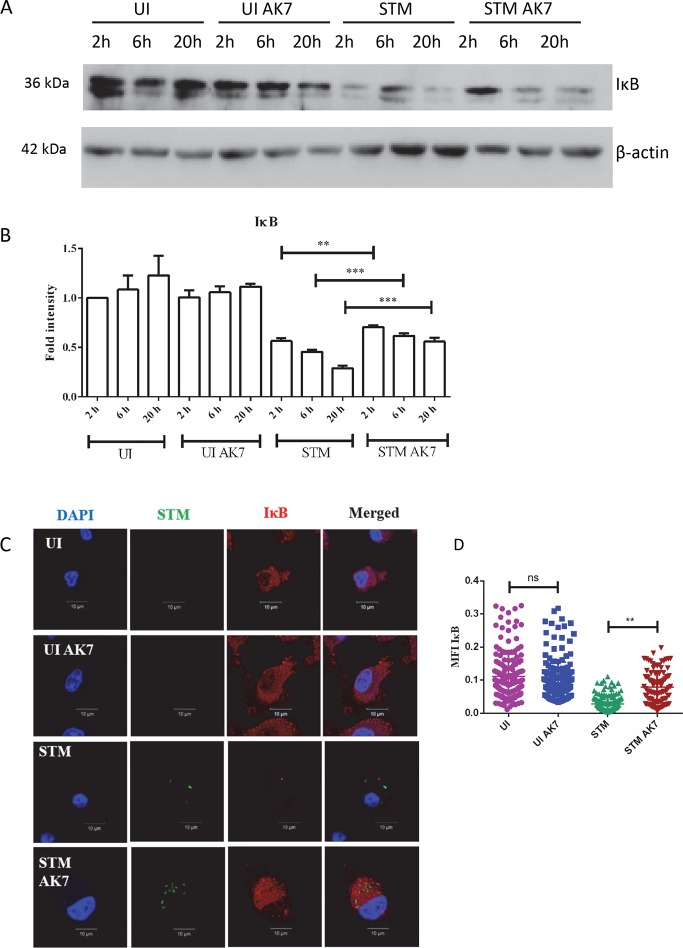
SIRT2 inhibition inhibits IκB degradation.A. Representative immunoblot of IκB in the presence and absence of SIRT2 inhibition at the indicated time point post infection. (UI- uninfected DCs, UI AK7- Uninfected DCs treated with 10 μM AK7, STM- Salmonella Typhimurium infected DCs, STM AK7- Salmonella Typhimurium infected DCs treated with 10 μM AK7). B. Densitometry analysis of IκB immunoblot in the presence and absence of SIRT2 inhibition at the indicated time point post infection. (UI- uninfected DCs, UI AK7- Uninfected DCs treated with 10 μM AK7, STM- Salmonella Typhimurium infected DCs, STM AK7- Salmonella Typhimurium infected DCs treated with 10 μM AK7) (Data are presented as mean ± SEM of 3 independent experiments). C. Representative immunofluorescence image of IκB in the presence and absence of SIRT2 inhibition at the indicated time point post infection. (UI- uninfected DCs, UI AK7- Uninfected DCs treated with 10 μM AK7, STM- Salmonella Typhimurium infected DCs, STM AK7- Salmonella Typhimurium infected DCs treated with 10 μM AK7) D. Mean Fluorescence Intensity (MFI) of immunofluorescence image of IκB in the presence and absence of SIRT2 inhibition at the indicated time point post infection. (UI- uninfected DCs, UI AK7- Uninfected DCs treated with 10 μM AK7, STM- Salmonella Typhimurium infected DCs, STM AK7- Salmonella Typhimurium infected DCs treated with 10 μM AK7) (Red- IκB, Green- Salmonella Typhimurium, Blue-DAPI) (n = 200) (unpaired two-tailed Student’s t- test, p- value, *** < 0.0001, **<0.001, *<0.01).